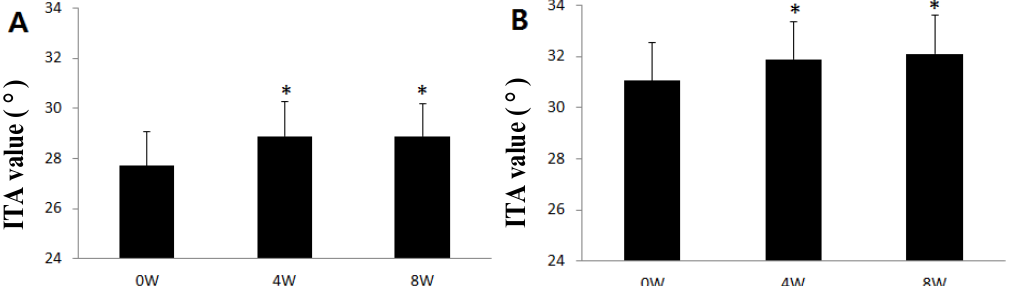
Figure 5. Changes in skin color (ITA value) following 8 consecutive weeks’ use of corn silk extract (mean ± SEM, * p < 0.05 vs. before treatment). ( A ) corn silk extract 0.75% aqueous solution; ( B ) corn silk extract 1.5% aqueous solution.